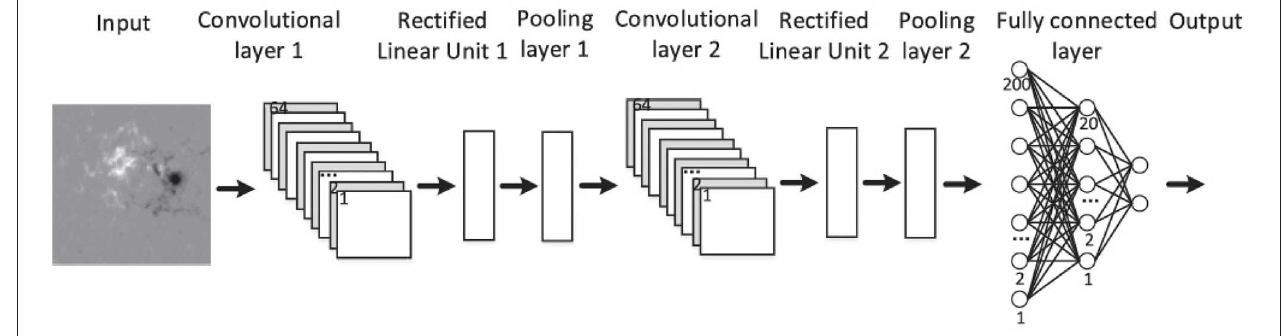
FIGURE 4 | Structure of the convolutional neural network in the deep learning method for flare forecasting. The method uses the line-of-sight magnetogram as input. This Figure is adapted from Huang et al.